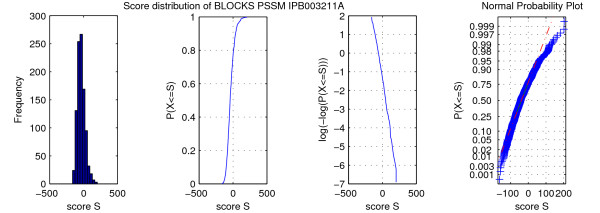
Score distribution of BLOCKS PSSM IPB003211A. Histogram, cumulative score distribution, X-Y plot, and normal probability plot of a PSSM taken from the BLOCKS database (Accession: IPB003211A; PSSM length m = 40), describing the UreI protein of Helicobacter pylori, a proton gated urea channel [36].